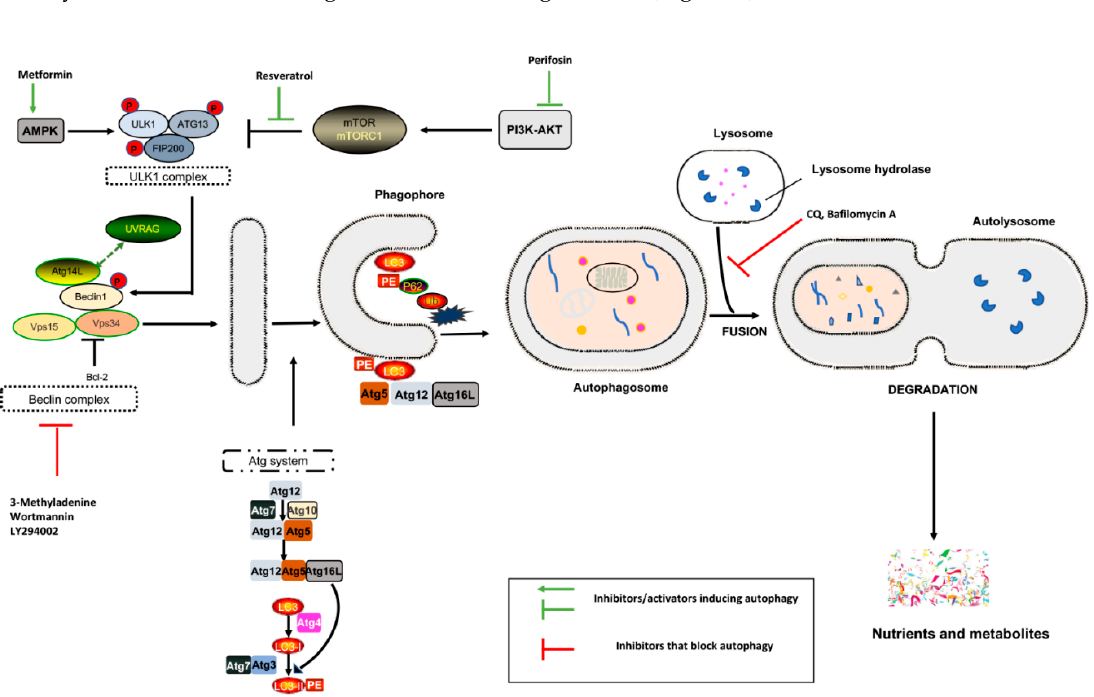
Figure 1. Schematic representation of regulatory pathways involved in the autophagic event and point of inhibition / activation. Under a deprivation of nutrients or growth factors, ULK activation occurs via the activation of activating AMP kinase (AMPK) and / or the inhibition of mTOR. ULK functions in a complex with FIP200 and Atg13, which phosphorylates Beclin-1, leading to VPS34 activation and phagophore formation. Association between Beclin-1 and Bcl-2 inhibits autophagy. Two ubiquitin-like conjugation systems are engaged, one involving Atg12, Atg5, and Atg16L proteins, and the other converting LC3 protein from its LC3I form to LC3II. This event leads to closure of an elongated phagophore with the formation of a mature autophagosome, which is followed by transport of the autophagic cargo to lysosomes, degradation of this cargo by lysosomal hydrolases, and recycling of the products for use in metabolism.